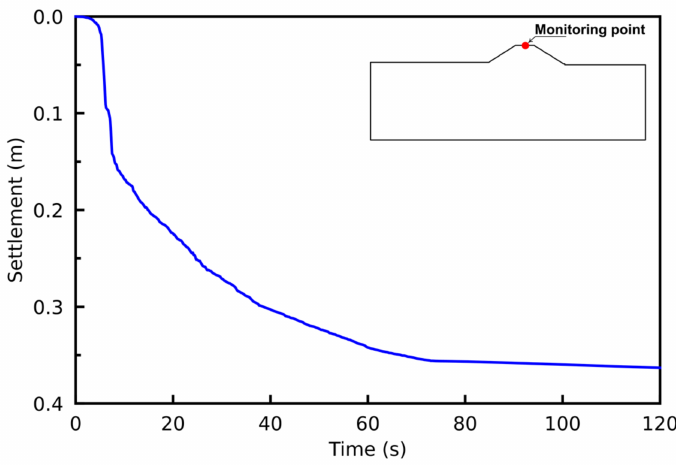
Figure 23. The displacement field after earthquake.